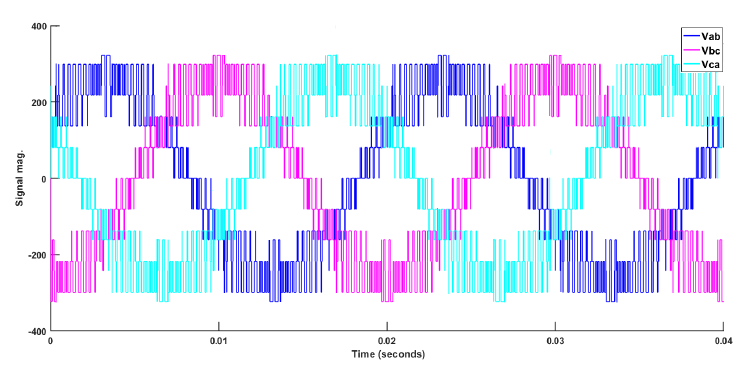
Figure 13. AHMMC output line voltages at M f = 1.